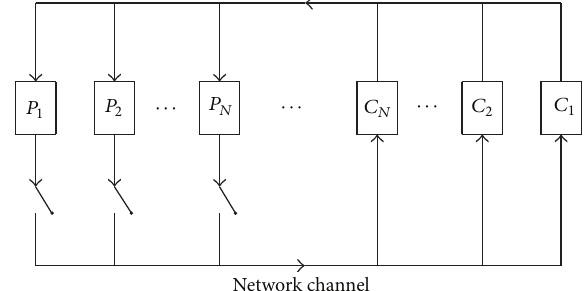
Figure 1: A shared